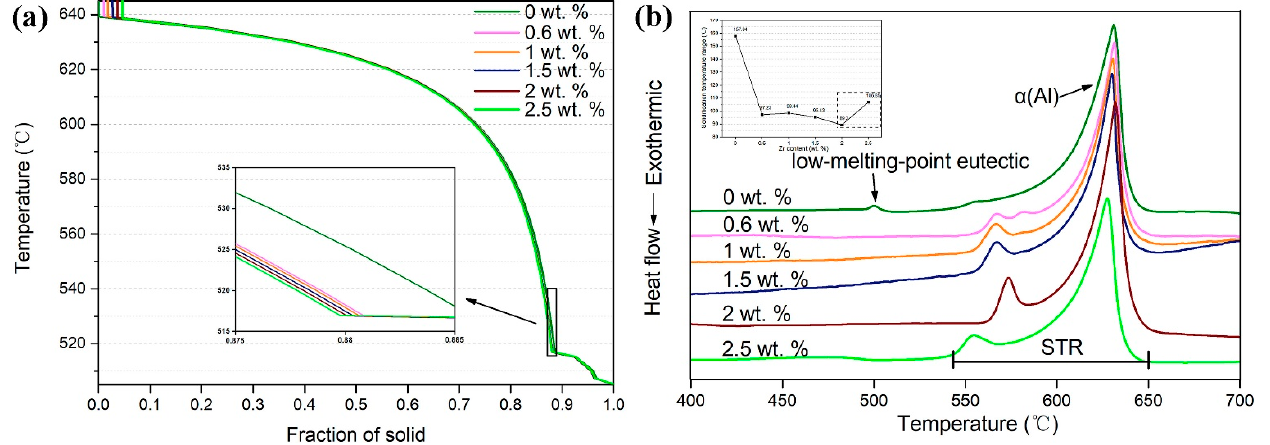
Figure 15. ( a ) Scheil ‐ Gulliver simulation and ( b ) DSC analysis of the solidification temperature range (STR) for different concentrations of Zr additions. Reproduced with permission from Elsevier [142].